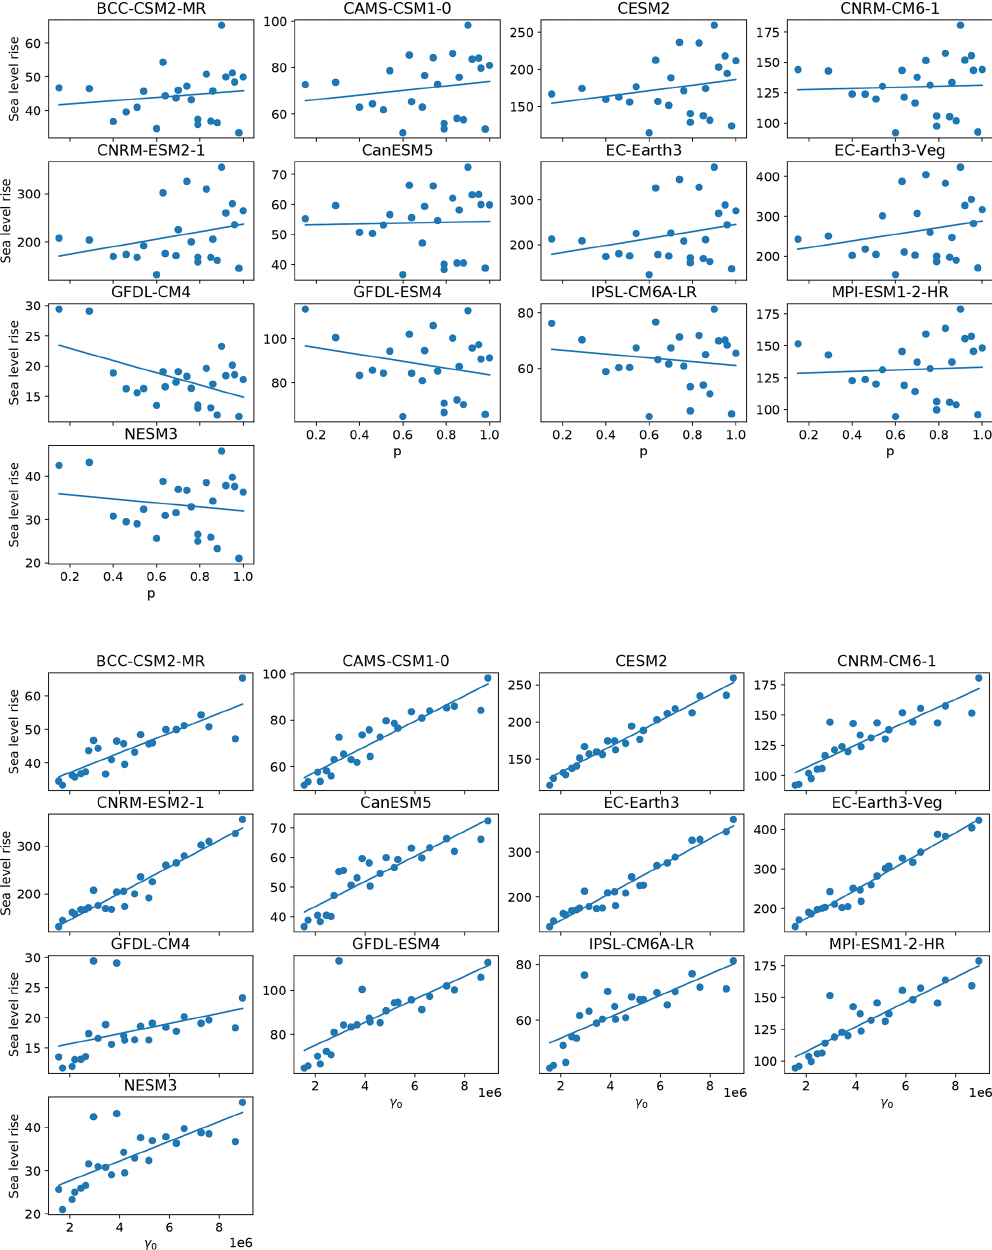
Figure A8. SLR as a function of p and γ 0 in the East Antarctic Ice Sheet (EAIS) region.